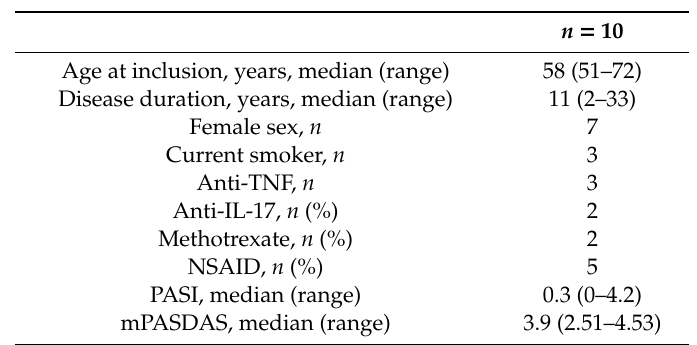
Table 1. Patient